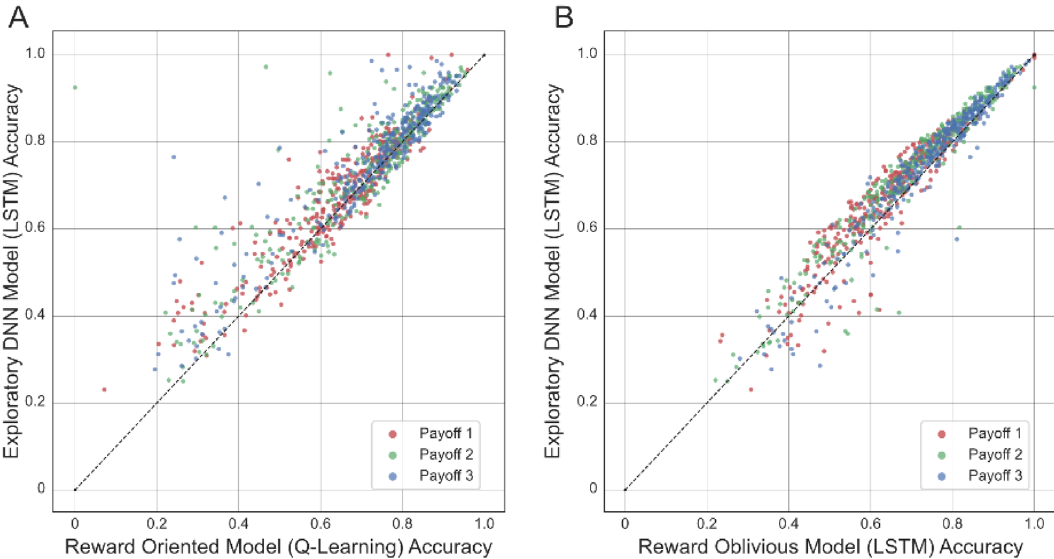
Figure 2. Comparison of the exploratory DNN and the reward-oriented ( A ) and reward oblivious ( B ) models’ accuracies across participants. Different colours mark the different payoff structure the participants experienced. Dots in the top triangle represent participants whose actions were more accurately predicted by the Exploratory DNN model than by the explicit